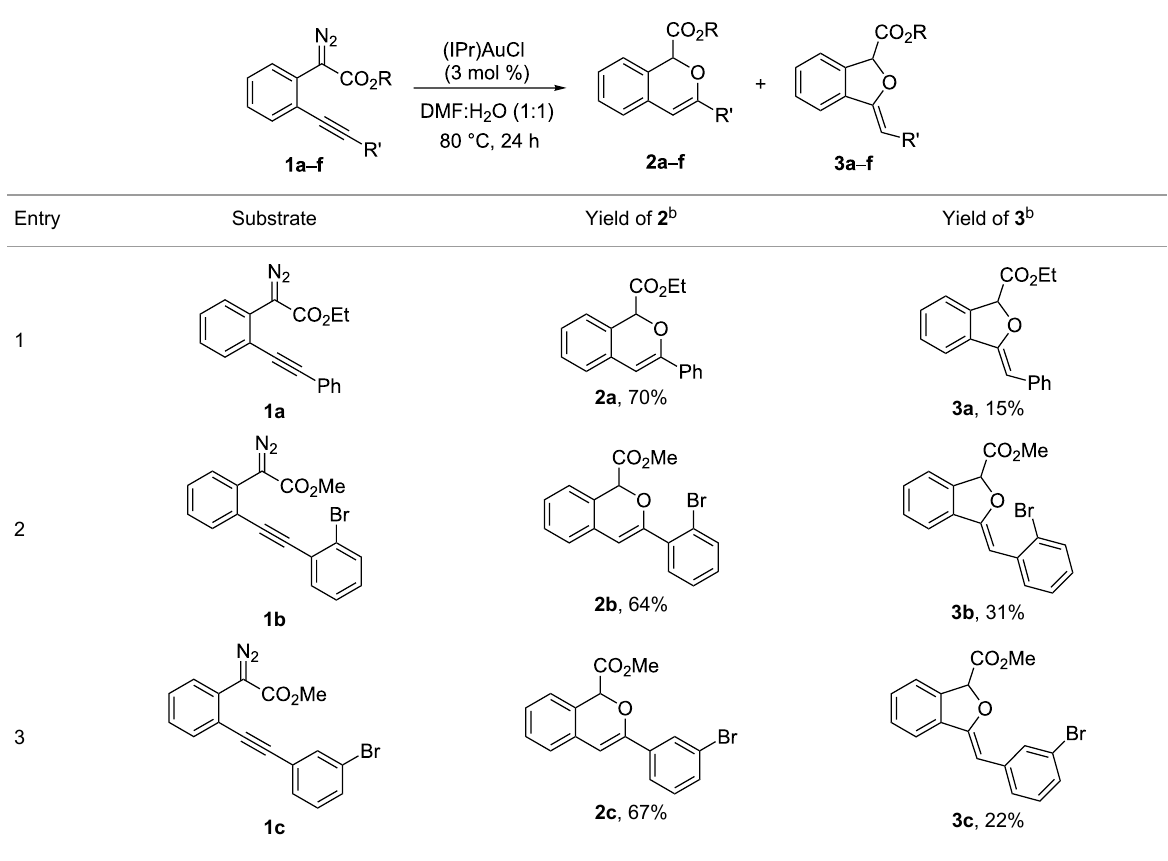
Entry Substrate Yield of 2 b Yield of 3